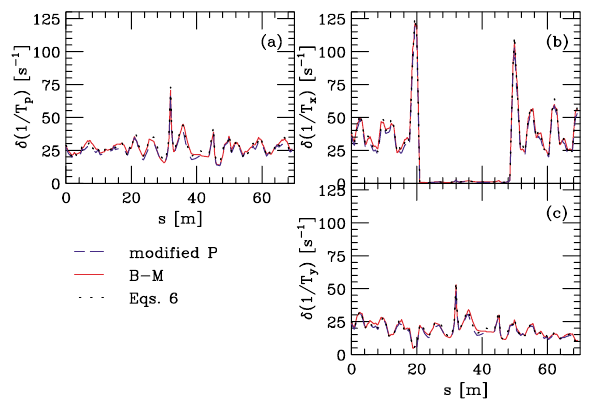
FIG. 2. (Color) Steady-state (local) growth rates over 1 (cid:1) 2 the ATF for an example with vertical dispersion due to random errors. Given are results due to modified Piwinski, Bjorken- Mtingwa, and Eqs. (6). TABLE II. Steady-state IBS growth rates for an example in- cluding vertical dispersion due to random errors. Method